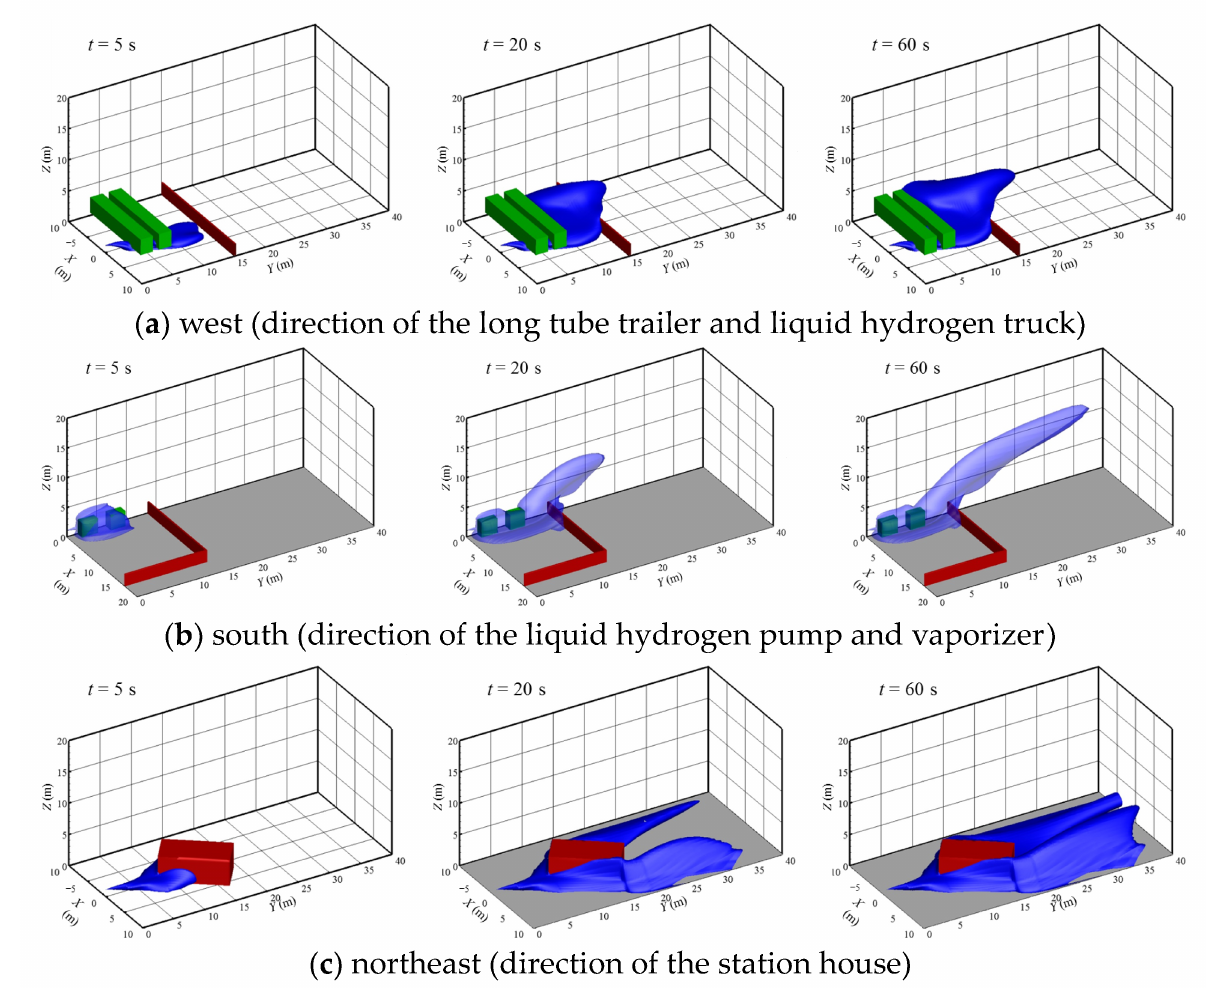
Figure 9. Diffusion contours of hydrogen cloud with different leakage